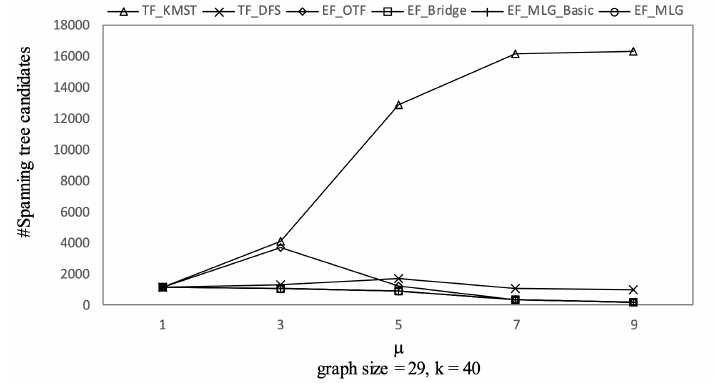
Figure 26. Spanning tree pruning on Ncfu vs. µ with graphsize = 29 and k =